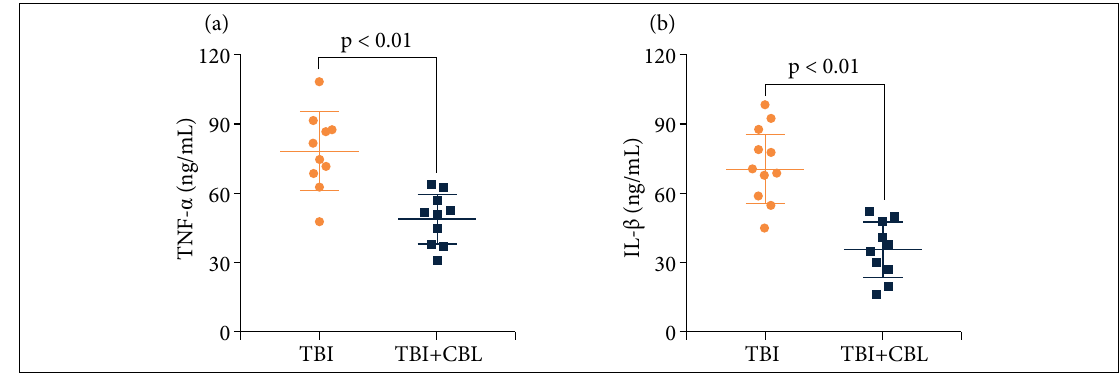
Figure 6 - CBL alleviates neuroinflammation in TBI patients. CBL significantly reduced TBI patients’ serum (a) TNF- α , (b) interleukin-1 β (IL-1 β ) levels at 72 h after TBI (n = 10, P < 0.01, analysis of variance; means ± SDs).